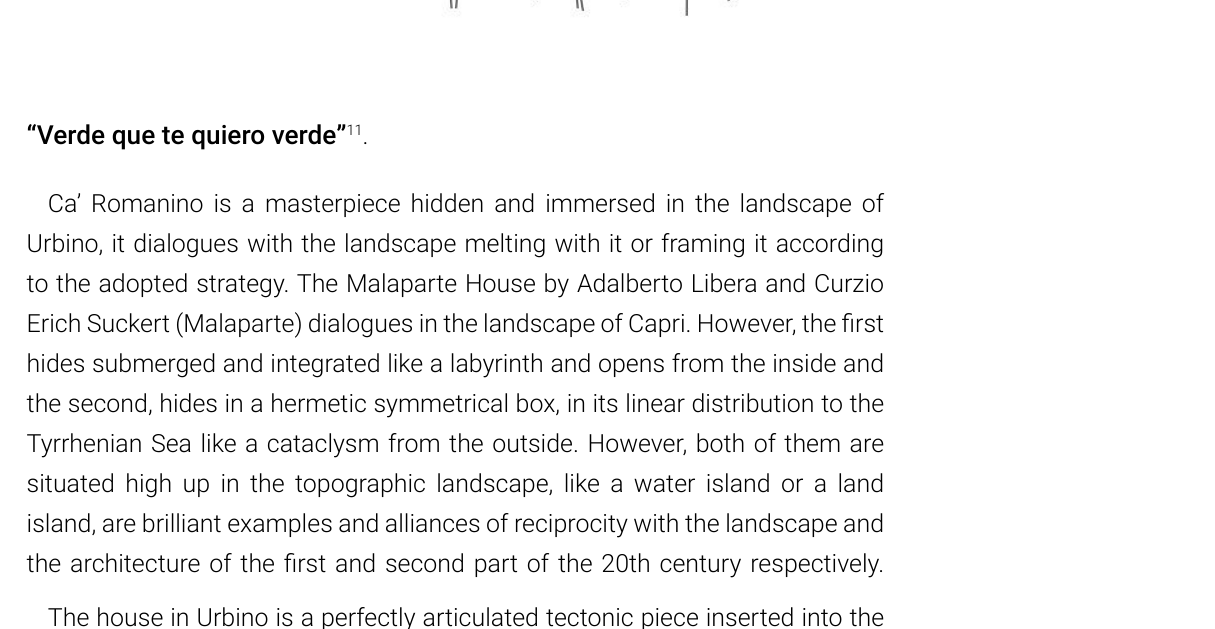
integrated with the pre-existing trees. Source: Line drawings by the